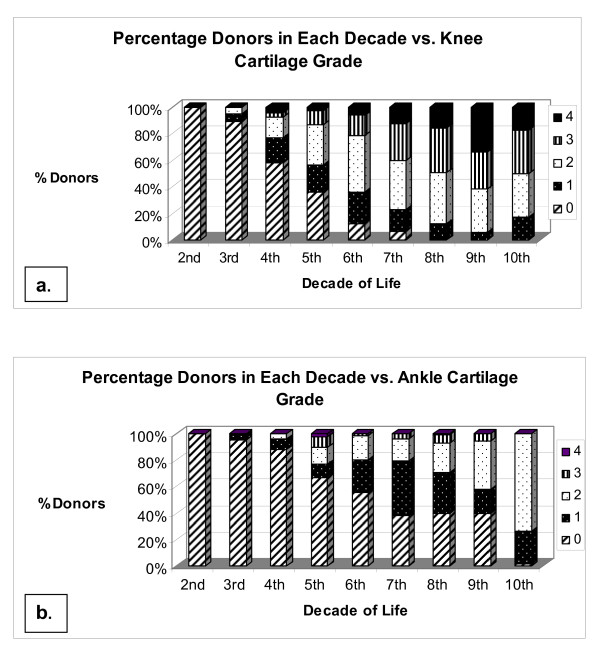
(a) and (b) Distribution of grades per decade for (a) knee and (b) ankle joints. By the third decade, the severity of knee grades increased in comparison to the ankle. By the eighth decade, no knee was normal in appearance, whereas some normal tali were observed into the tenth decade.